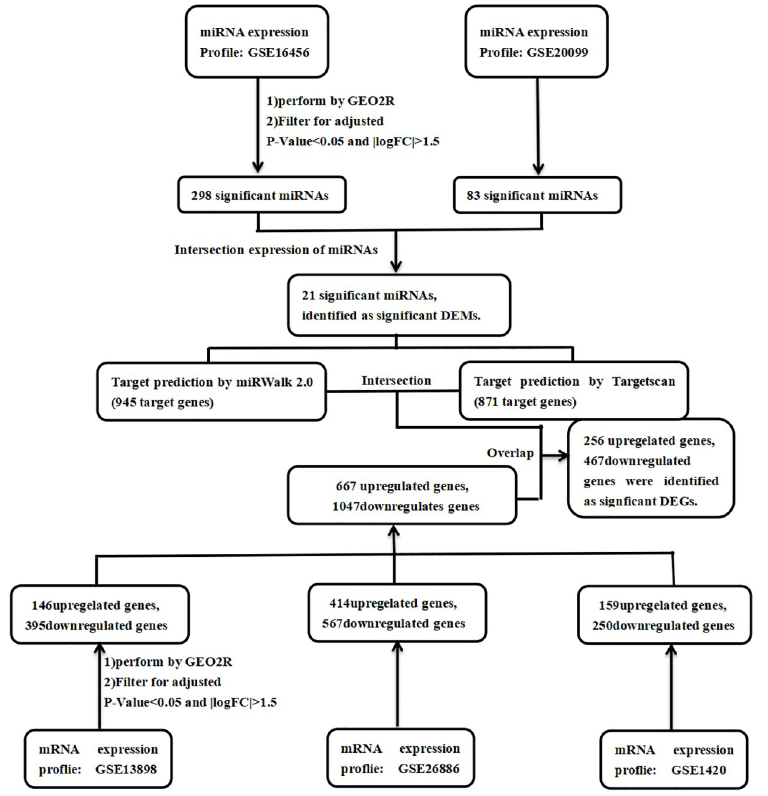
Fig 1. Flowchart of bioinformatics